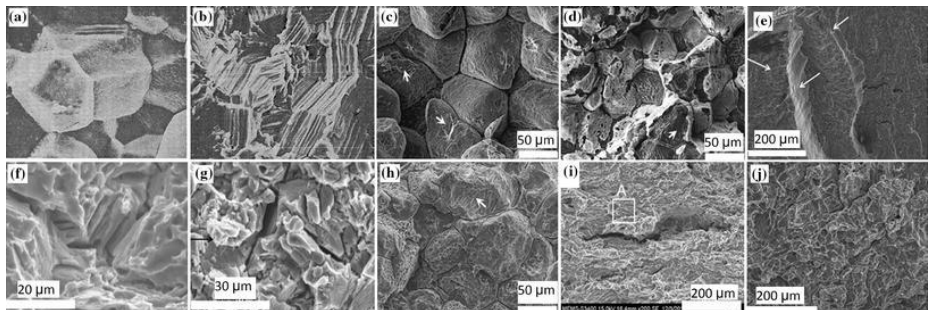
Figure 26. SEM fractographs of various Mg biomaterials that fractured by SCC in different solutions. ( a ) and ( b ) represent crack propagation by an anodic dissolution mechanism in in NaCl + K 2 CrO 4 solution; the rates of film rupture and regrowth compete. ( a ) IGSCC, ( b ) TGSCC of Mg – Al alloy. (c) through (h) represent crack propagation by a mixed-mode mechanism. ( c ) IGSCC of ZE41 in NaCl. The IGSCC is associated with second-phase particles along grain boundaries. ( d ) TGSCC of QE22 in NaCl. The TGSCC fracture path is consistent with a mechanism involving hydrogen. ( e,f ) TGSCC of ZX50 and WZ21 in modified simulated body fluid (m-SBF), respectively. The electrochemical breakdown or mechanical rupture of the protective film resulted in entry of hydrogen into the alloy matrix and subsequent embrittlement. ( g ) IGSCC of WE43 in m-SBF. The intergranular cracking (IGC) is associated with electrochemical dissolution along the grain boundaries. ( h ) IGSCC and TGSCC of EV31A in NaCl. While the IGC is due to the presence of bulky precipitates at grain boundaries, the transgranular cracking (TGC) is due to hydrogen entry into the matrix. (i) and (j) represent hydrogen-assisted cracking mechanism. ( i ) TGSCC of Mg – Mn in NaCl. TGSCC with the evidence of flat parallel facets is an indication of the hydrogen-assisted cracking. ( j ) TGSCC of AZ91D in m-SBF. Fracture of protective films at the crack surface allows hydrogen to diffuse into the alloy matrix [307]. Reprinted with permission from Springer Nature.